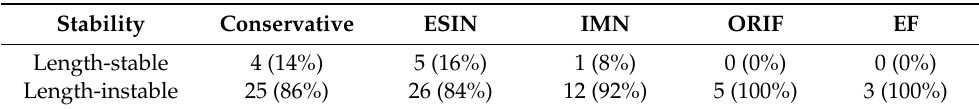
Table 1. Portion of length-stable and length-instable fractures of the femur shaft in the different treatment groups: conservative, flexible intramedullary nailing (ESIN), intramedular nail (IMN) and ORIF, external fixator